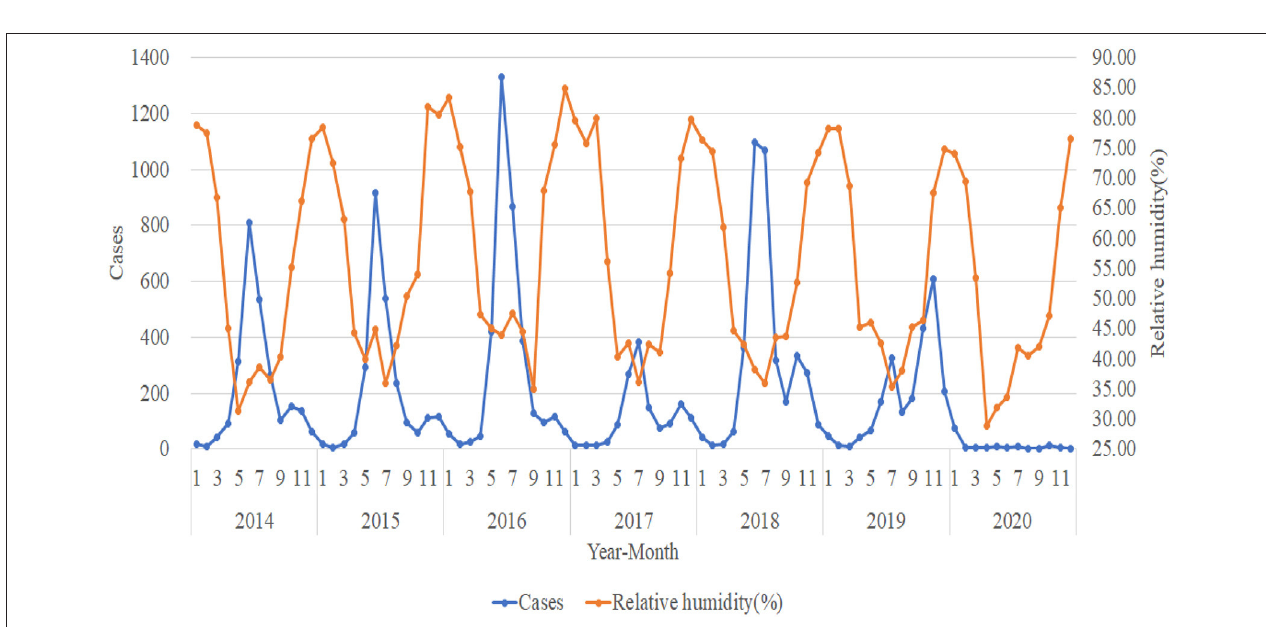
FIGURE 3 | Trends in the number of HFMD cases and relative humidity (%).